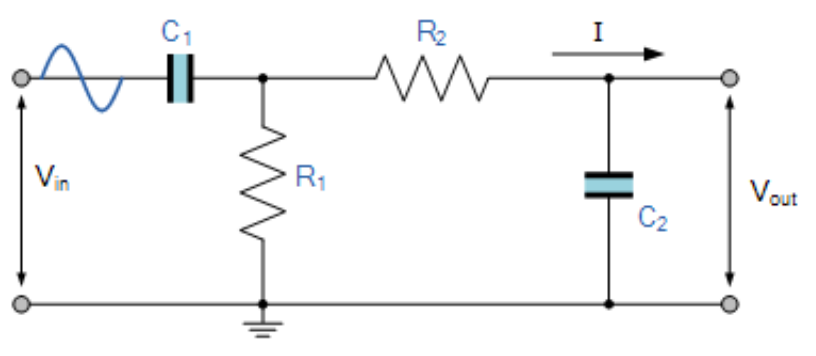
Figure 3. Passive bandpass filter [4]